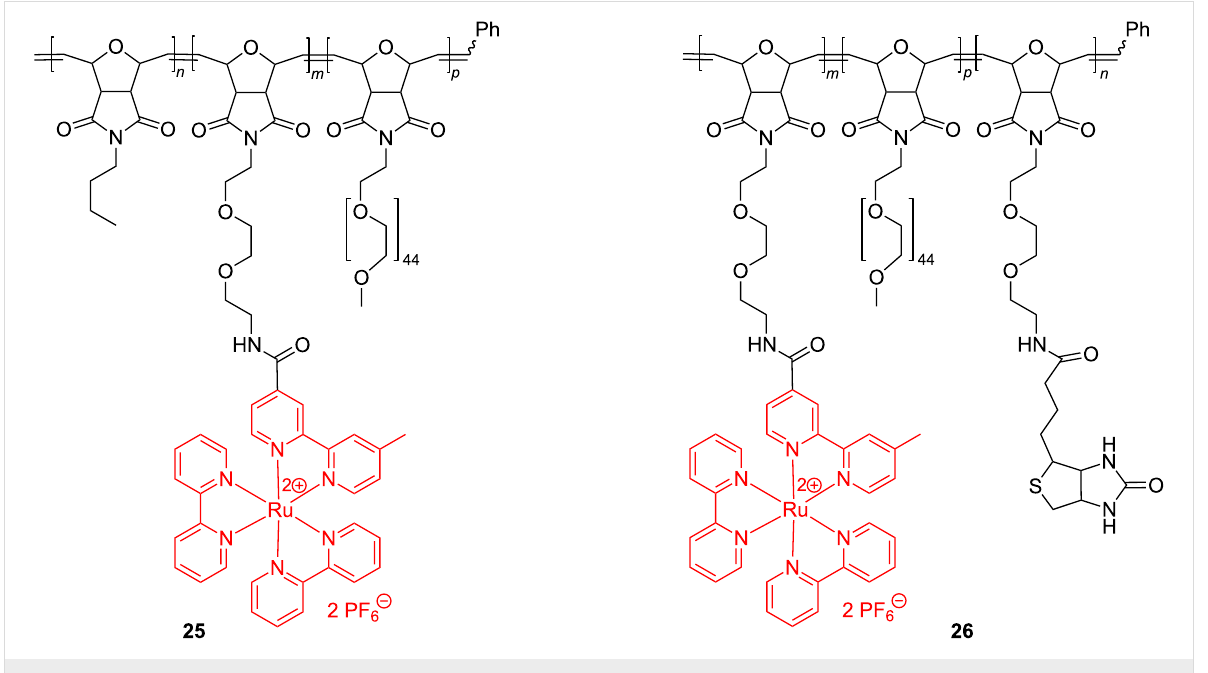
Scheme 11: Synthesis of Ru triblock copolymers.